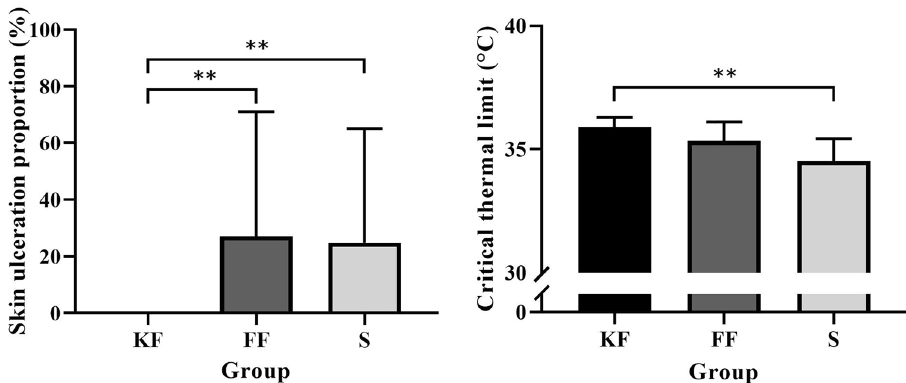
Figure 4. Skin ulceration proportion of Apostichopus japonicus covered with ulcers after the exposure to infectious solution in the three groups (mean ± SD, N = 20, left). CT max of A. japonicus in the three groups (mean ± SD, N = 12, right). KF, FF, S refer to group KF, group FF and group S. The asterisk ** means P <